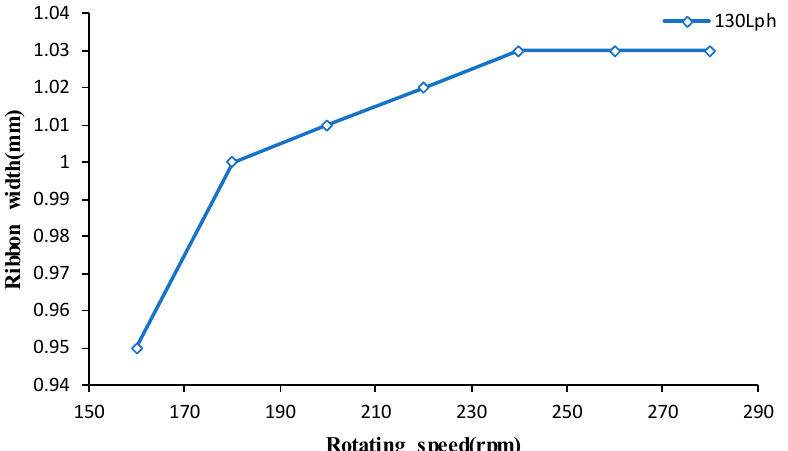
Figure 14. The variation of ribbon width with rotating speed.